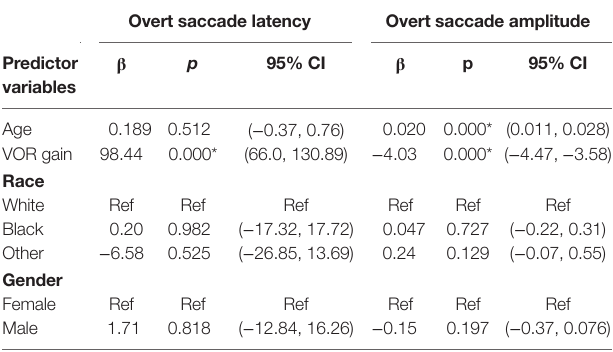
TaBle 3 | relationship between latency and amplitude of the first overt saccade and age controlling for VOr gain. Overt saccade